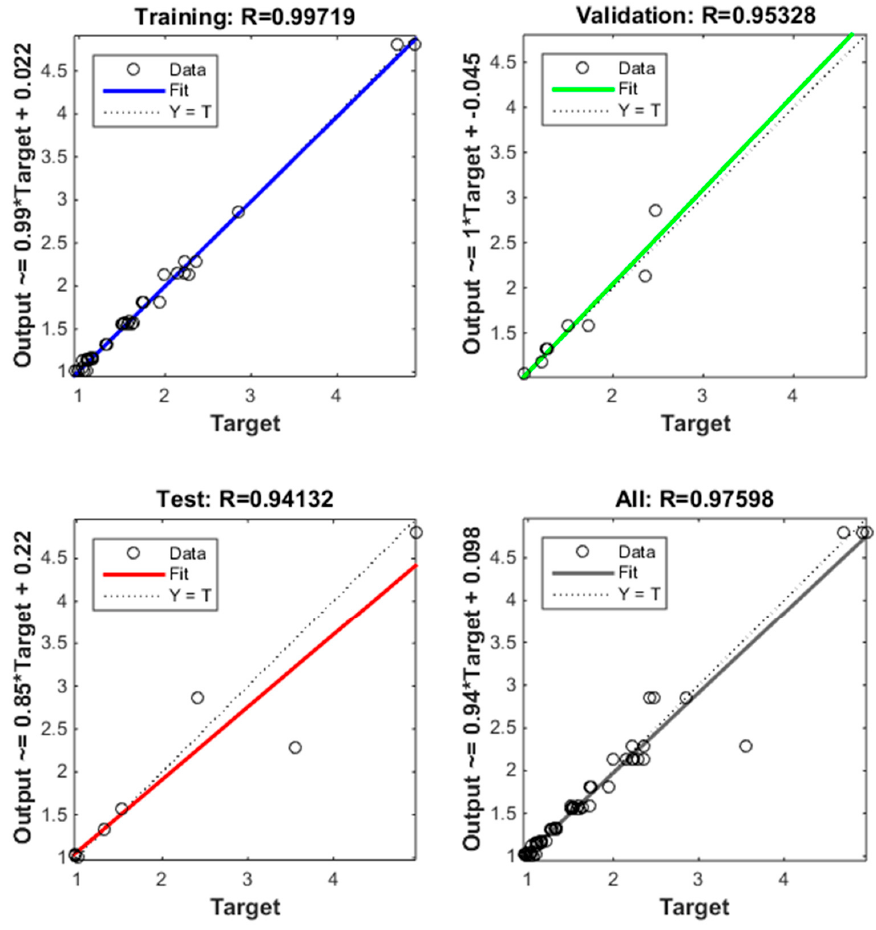
Figure 7. Regression analysis results obtained by the ANN architecture adopted, based on its validation performance.